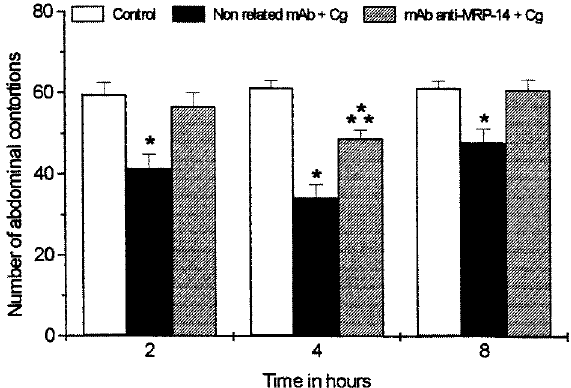
FIG. 4. Effect ofmAb anti-MRP-14 on antinociception induced by carrageenan (Cg) in animals submitted to the writhing test. ThemAb anti-MRP-14 was injected 5min before the i.p. injection of Cg and 2, 4 or 8h later submitted to the writhing test. Animals injected with non-relatedmAb were also evaluated. Controls were injected only with acetic acid. Values represent the mean ±S.E.M. of 8–16 animals for each group. * p < 0.05 in comparison with values obtained in